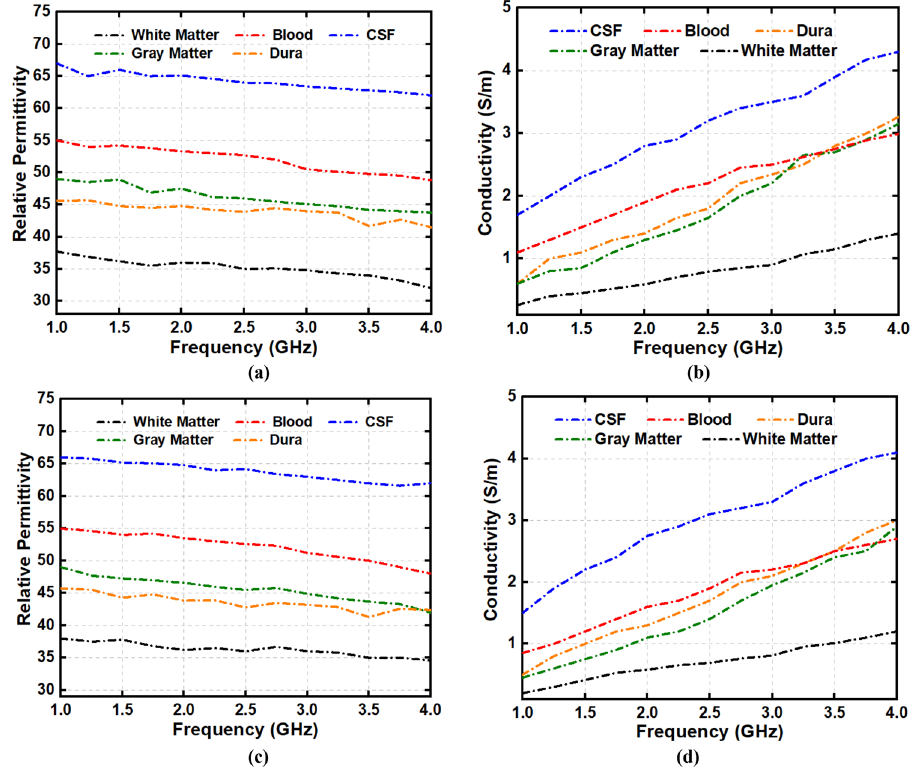
Figure 11. ( a ) Relative permittivity and ( b ) conductivity after 4 days; ( c ) relative permittivity and ( d ) conductivity after 7